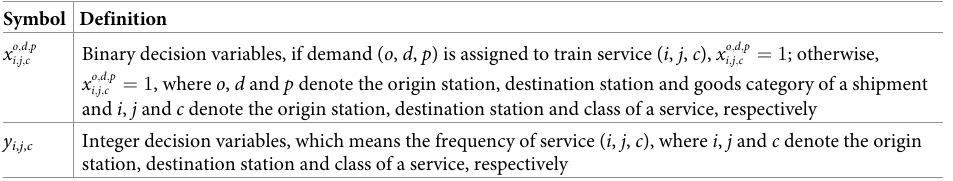
Table 3. Decision variables used in this